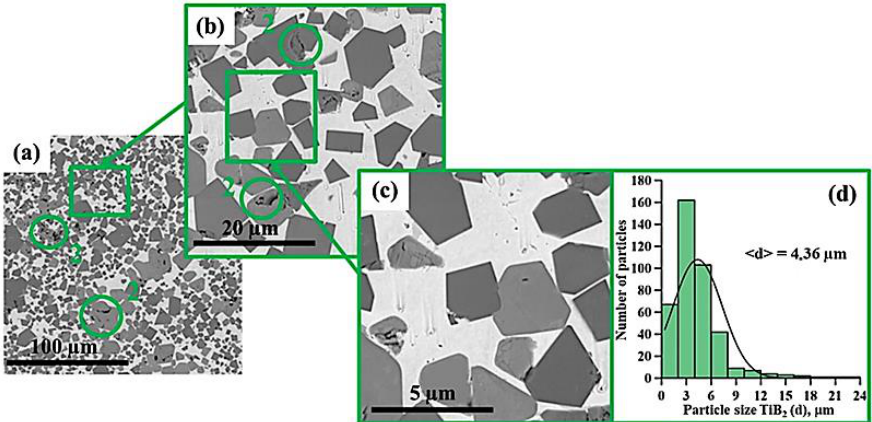
Figure 9. SEM image of the structure of a composite fabricated by direct laser deposition from the Inconel 625 + 70 wt% NiTi–TiB 2 powder mixture ( a – c ), histogram of the distribution of ceramic inclusions by size ( d ).